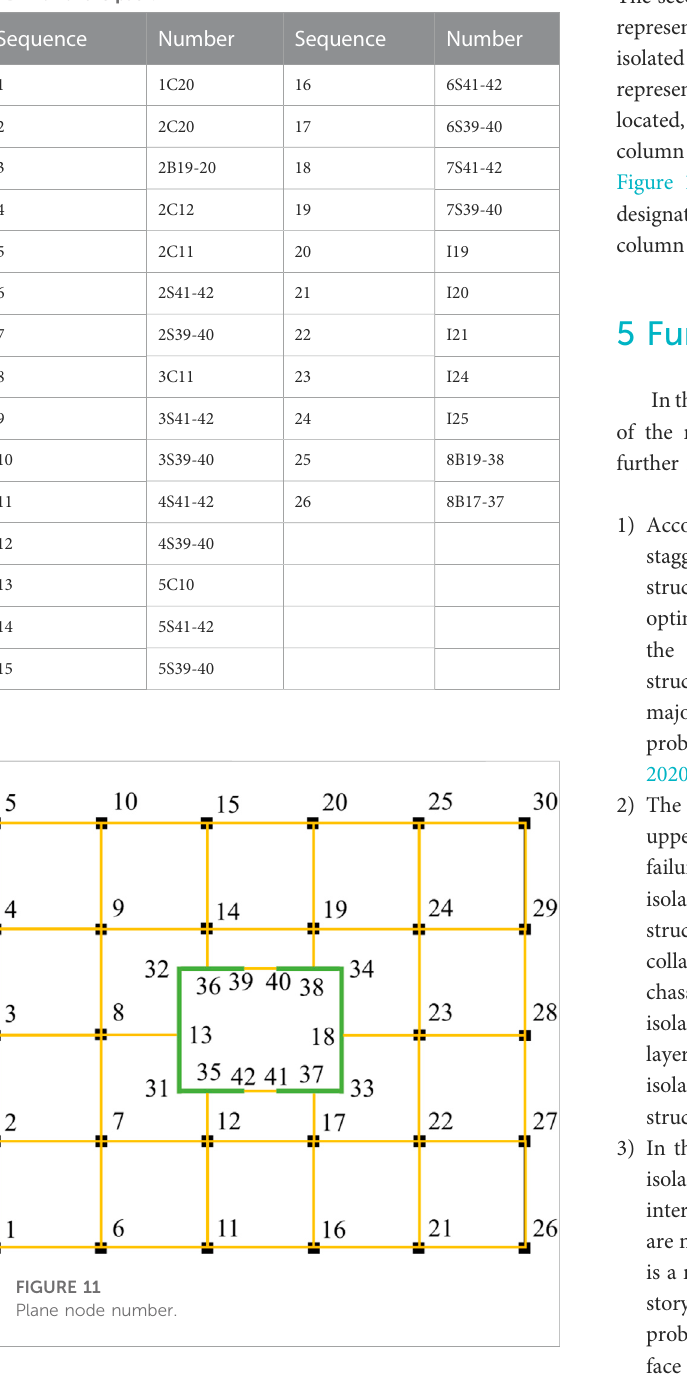
TABLE 6 Failure